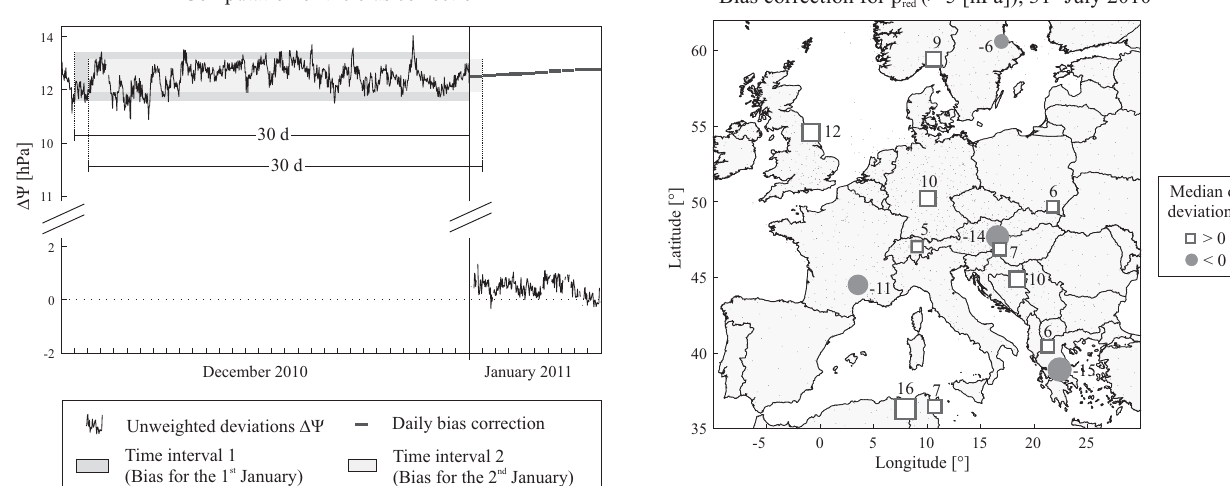
Fig. 6. Schematic illustration of computing a bias correction. The daily bias correction (dark solid horizontal bars starting at the be- ginning of January 2011) is defined as the median of the unweighted deviations (rough solid black line) within the user defined time in- terval (e.g. the last 30 days) and is valid for the next day. Note that the bias correction is allowed to vary and can automatically adapt to new situations (e.g. calibration of the instrument or changing station distributions).